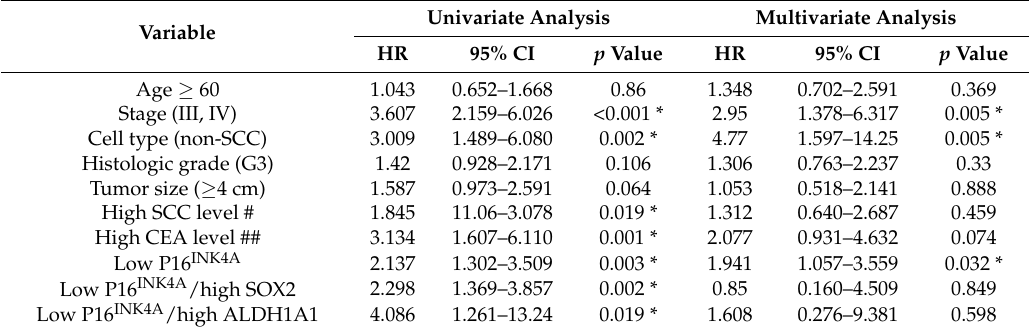
Table 2. Univariate and multivariate logistic regression analysis of the prognostic factors for